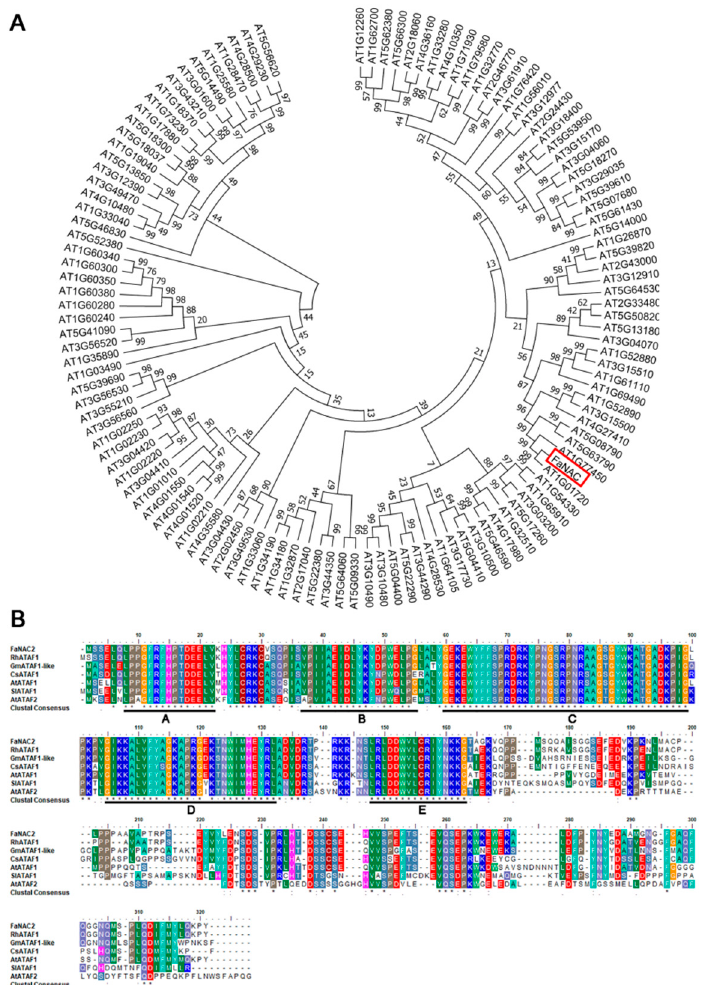
Figure 1. Phylogenetic analysis and amino acid sequence alignment of FaNAC2 . ( A ) Phylogenetic relationship between FaNAC2 (red boxed) from strawberry and NAC family members in Arabidopsis. MEGA 7.0 software was used to construct the Neighbor-Joining tree. The nearest NAC gene is AT1G01720 ( AtATAF1 or AtNAC2 ). ( B ) Protein sequence alignment of ATAFs. The black underlines indicate the conserved N-terminal domain of NAC family. A–E represent five conserved sub-domains.